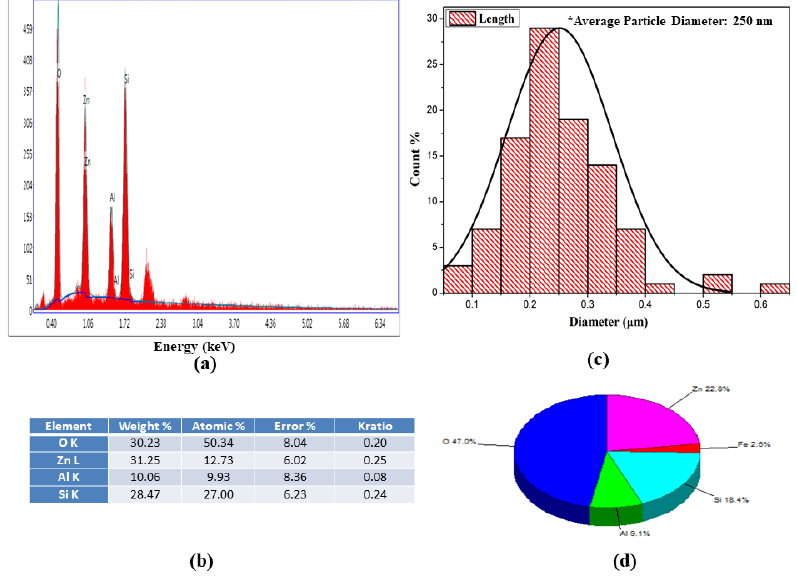
Figure 3. ( a ) Energy-dispersive X-ray patterns of gahnite ferroan composites; ( b ) particle size distribution of gahnite ferroan composites; ( c ) elemental analysis of gahnite ferroan composites; and ( d ) quantitative weight percentage of bulk gahnite ferroan composite.